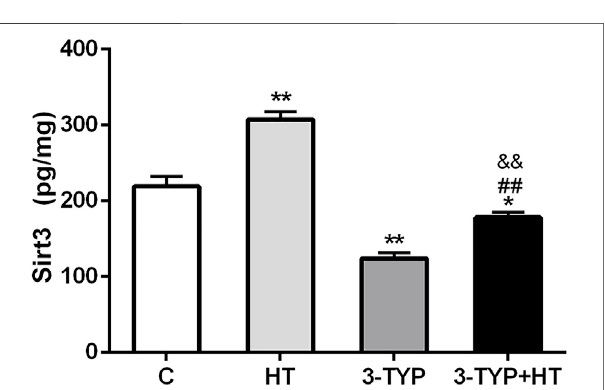
FIGURE 2 | Alterations of Sirt3 levels after Sirt3 inhibition and hypoxic traininginterventions. Figure2 werecomparisonsofSirt3activity (pg/ml)after interventions. C, control; HT, hypoxic training; 3-TYP, Sirt3 inhibitor 3-TYP; 3- TYP + HT, 3-TYP + hypoxic training. n = 6. * p < 0.05, ** p < 0.01 vs. C; ## p < 0.01 vs. HT. All the results were presented as mean ± SEM.